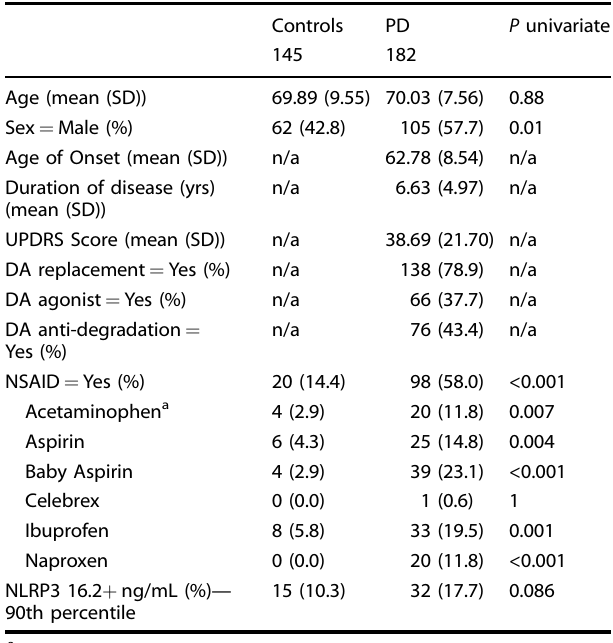
Table 1. Pooled population characteristics of samples obtained from Dartmouth Hitchcock Medical Center and the Harvard Biomarker Repository.